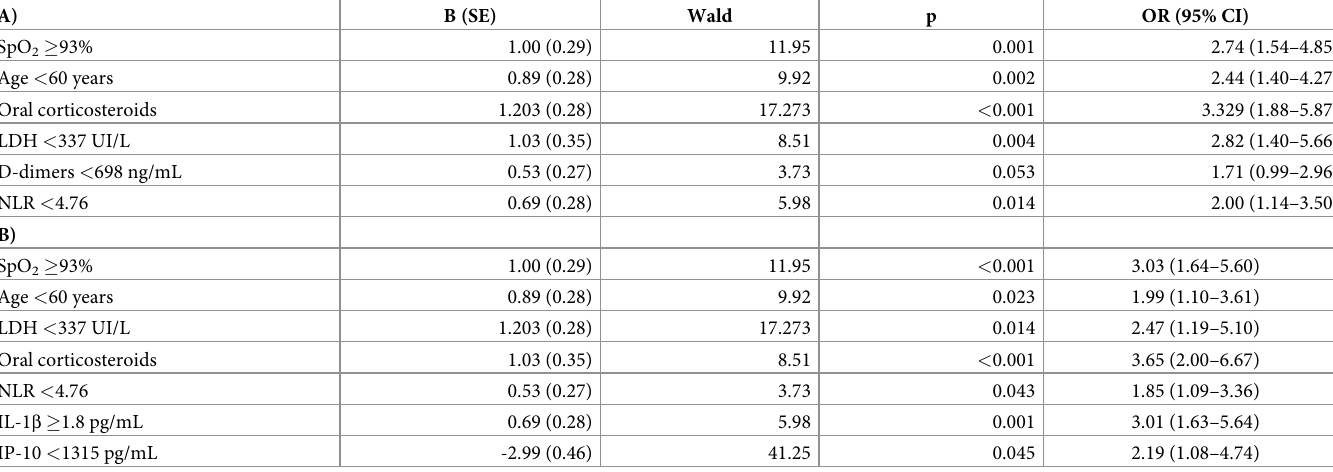
Table 2. Predictive models for early hospital discharge among mild patients at admission.